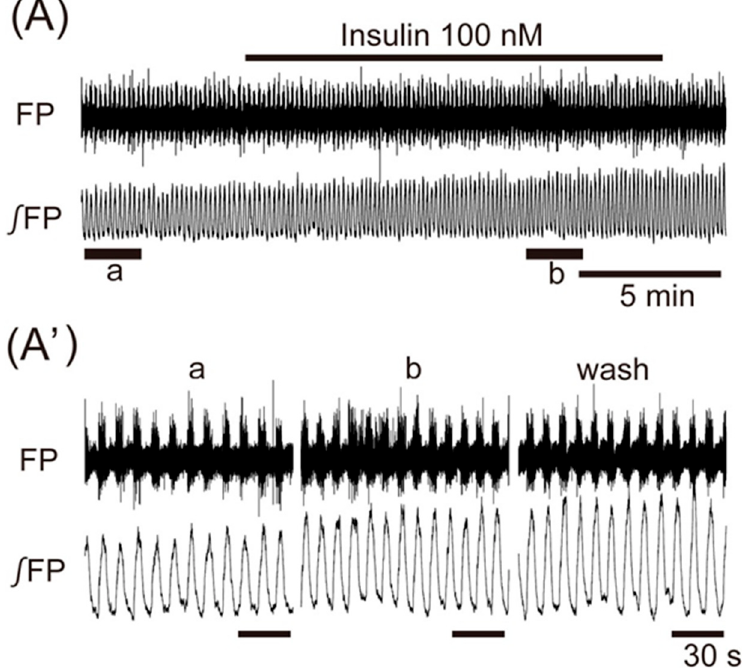
Figure 3. The effects of anorexigenic neuropeptide insulin on oscillation in the ventromedial hypothalamus. ( A ) An example of continuous recording of the ventromedial hypothalamus field potential before and after application of 100 nM insulin. ( A’ ) Faster sweep representations: a and b correspond to records at “a” and “b” in ( A ), and after 20-min washout (wash). The frequency of the oscillation was increased by the application of insulin. FP: raw field potential; ʃ FP: integrated field potential; wash: washout.